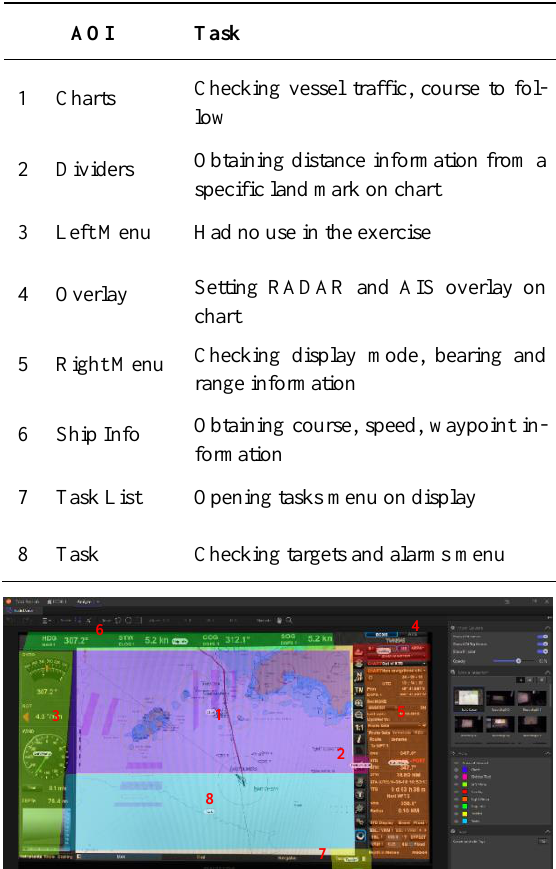
Table 2. List of areas of interest and corresponding tasks for ecdis exercise.